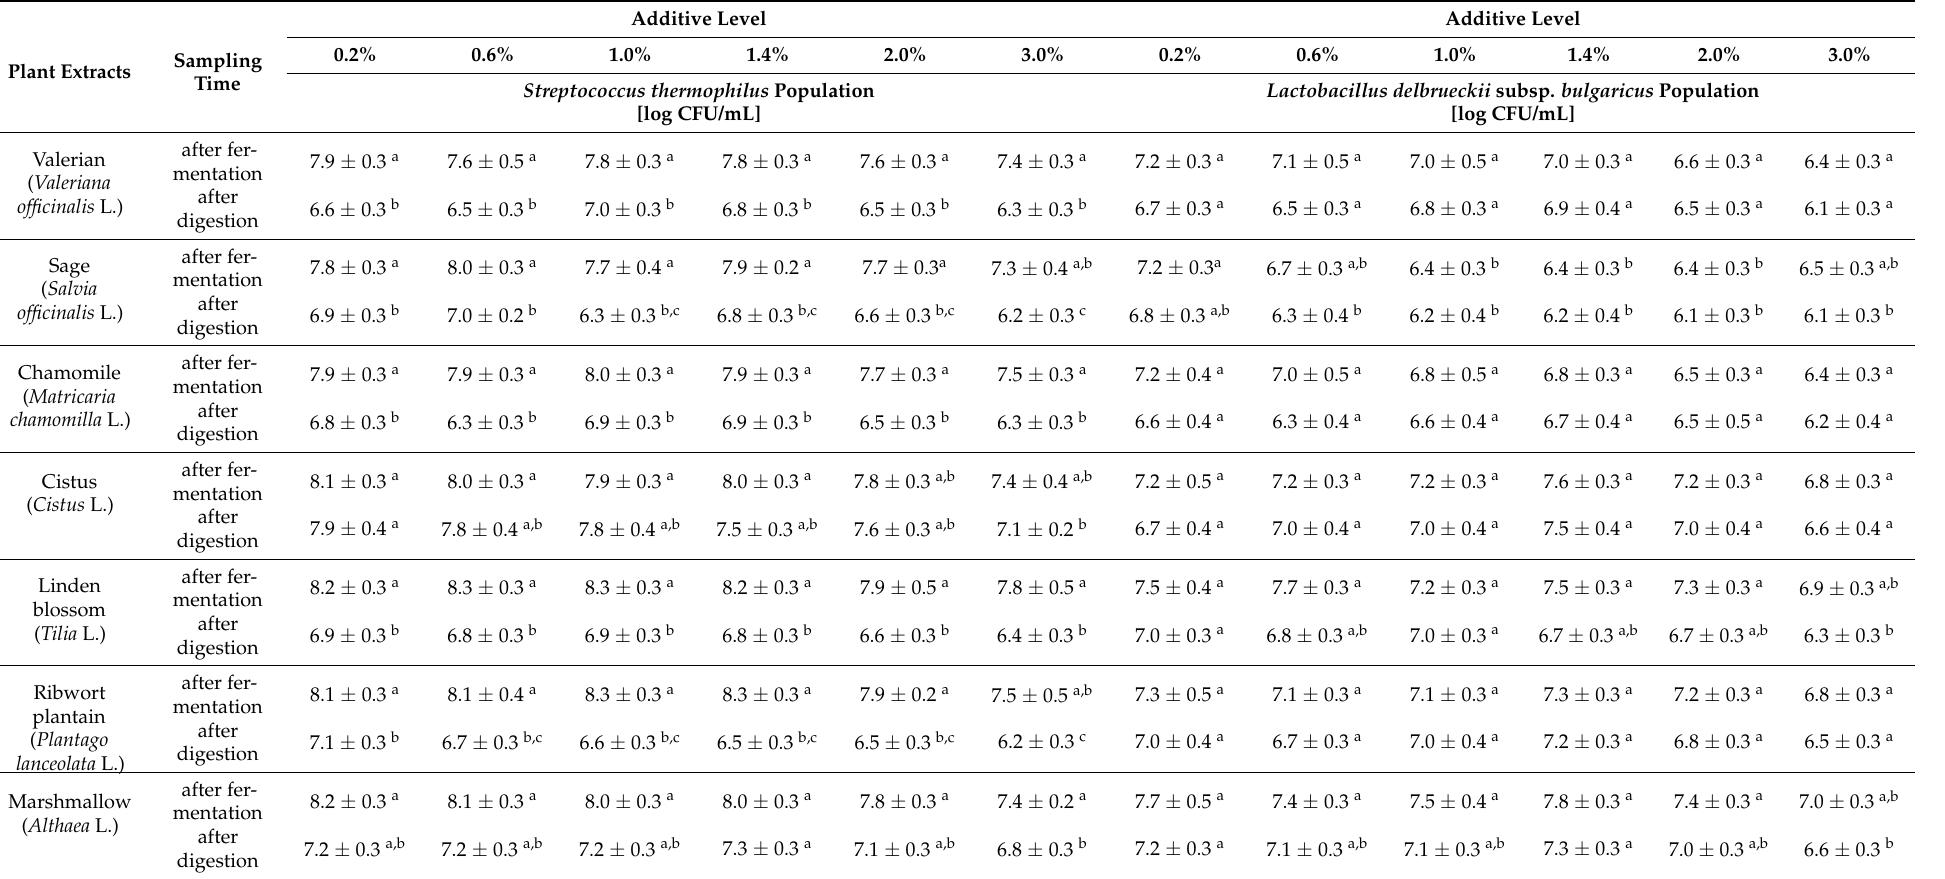
Table 1. The effect of plant extracts on the populations of lactic acid bacteria (average values and standard deviations of five